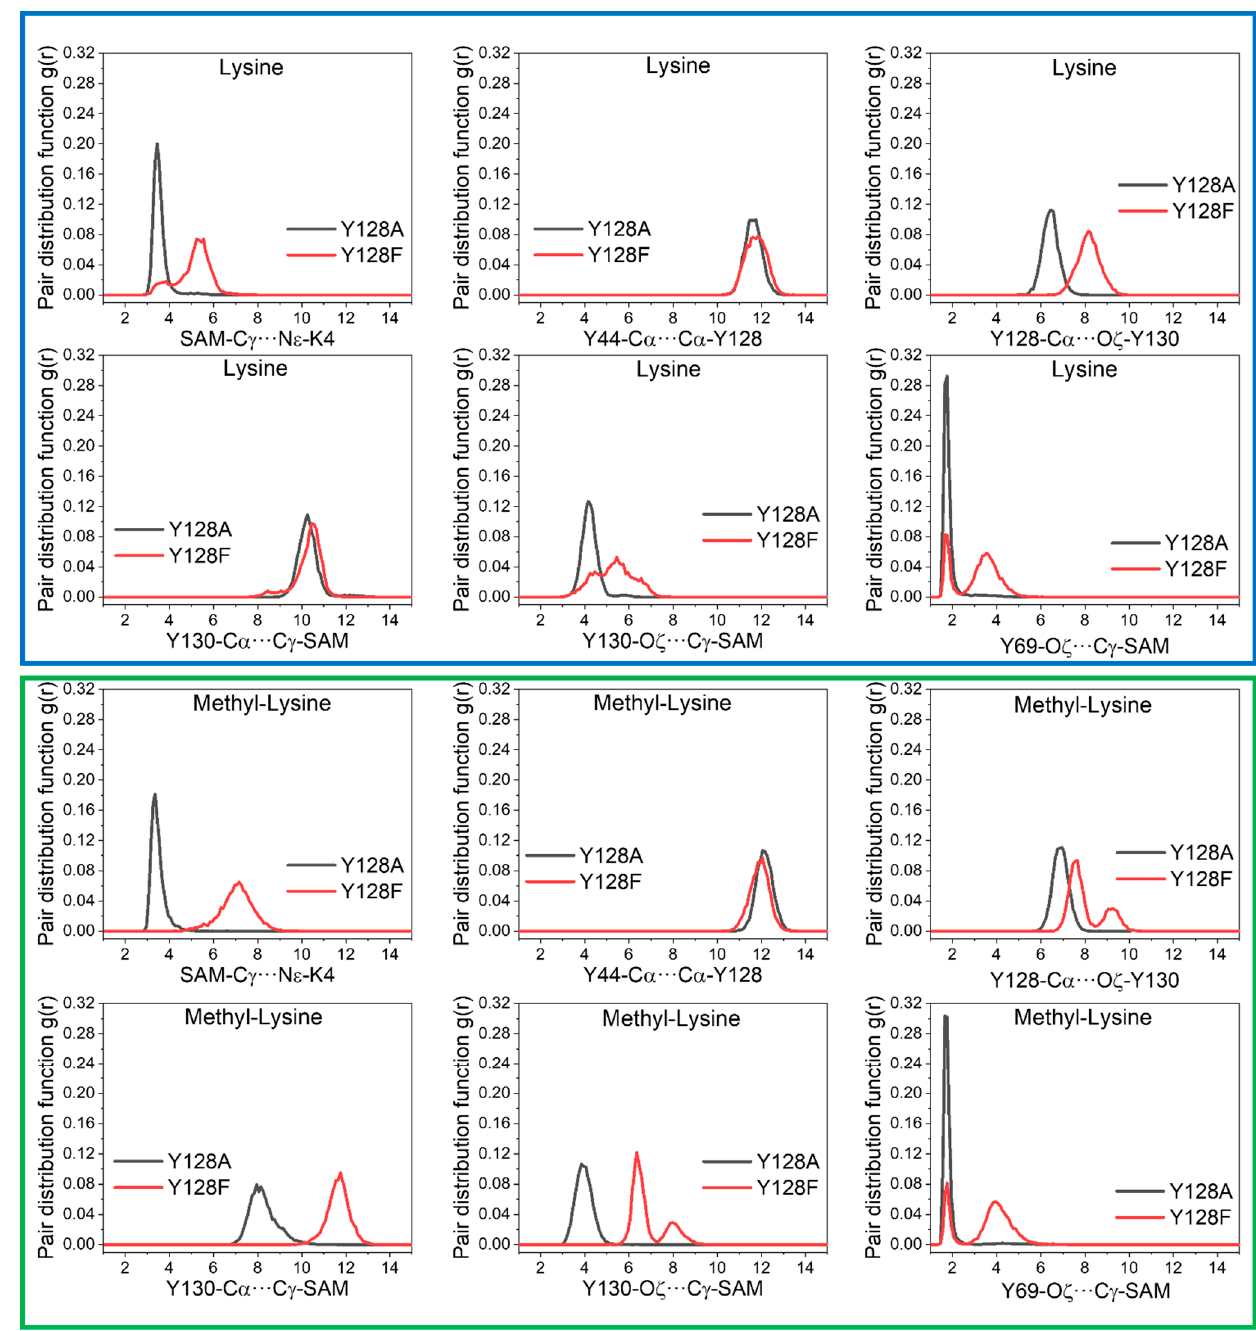
Figure 6. Plots of the pair-distribution functions for selected distances associated with the reactivation mechanism sampled along 50 ns of molecular dynamic simulations of Y128F and Y128A mutants with the unmethylated and mono-methylated lysines. In the blue box are the interactions involving Y128F and Y128A for the systems sampled to perform the first methylation process; in the green box are the interactions involving Y128F and Y128A for the systems sampled to perform the di-methylation process.